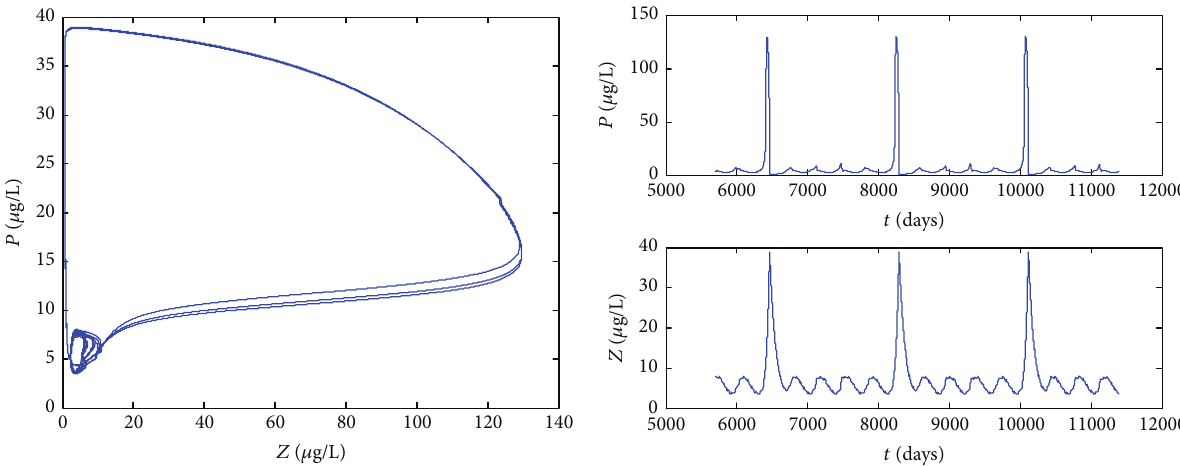
Figure 5: Phase portraits and time series of system (3) with initial values (𝑃(0),𝑍(0)) = (2, 5) when 𝜇 = 0.12 , 𝑄 = 0.5 , and 𝜏 = 57